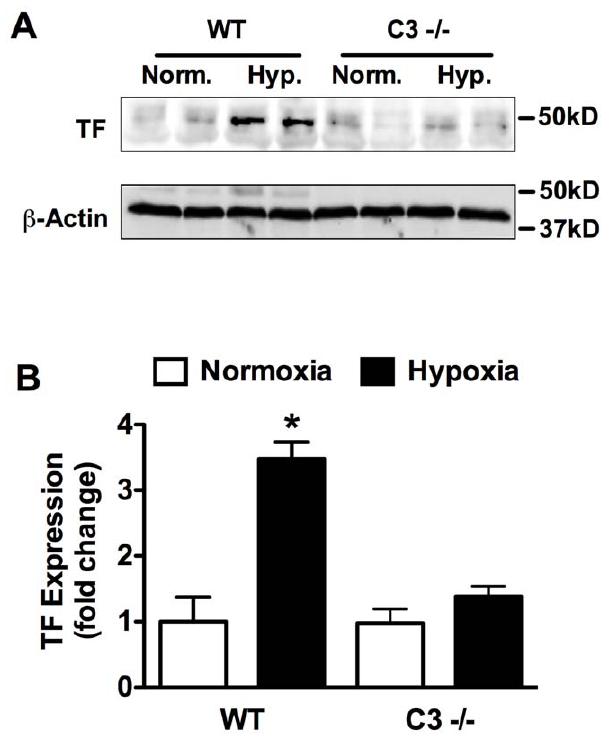
Figure 9. Loss of C3 prevents hypoxia-induced TF upregula- tion. (A) Representative Western blot analysis of normoxic or hypoxic WT and C3 2 / 2 lungs for TF expression. (B) Densitometric anlysis of Western blots from (A). Bars represent the mean 6 SD (n=4 animals per group). * P , 0.05.